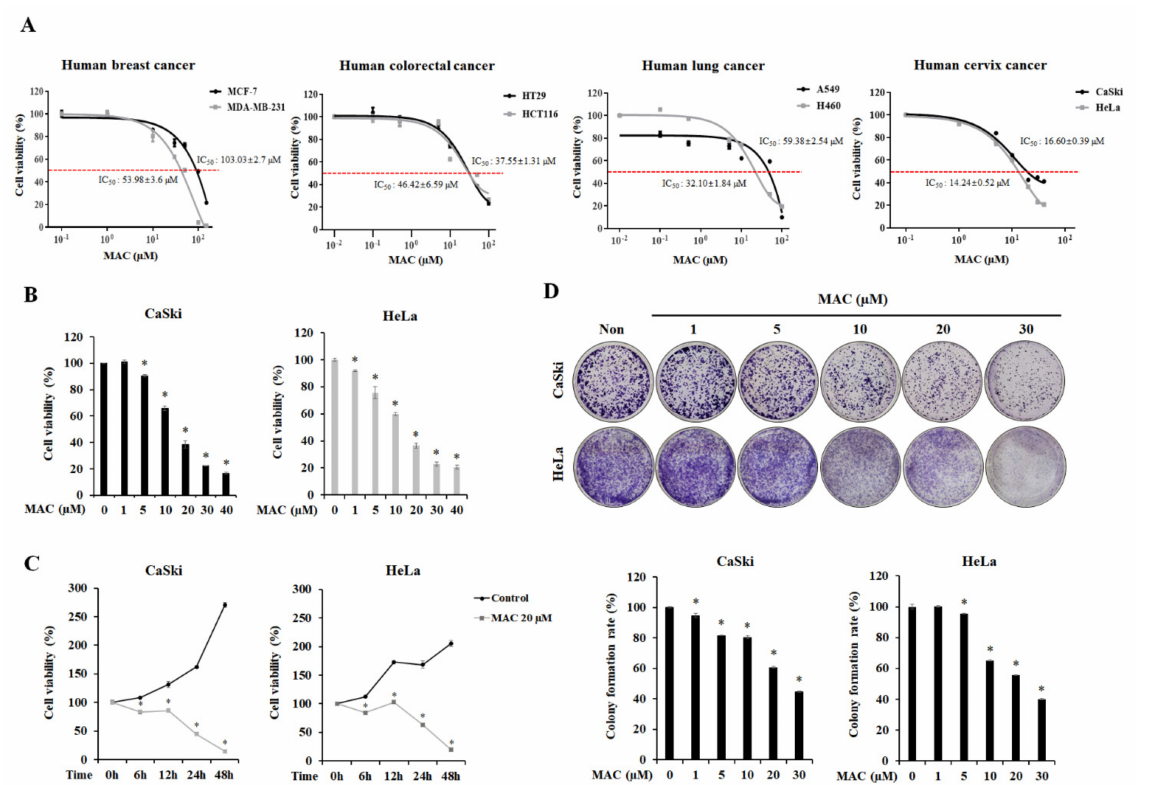
Figure 1. 4-O-methylascochlorin (MAC) suppresses the cell viability and proliferation in cervical carcinoma cells. ( A ) Various cancer cells treated with different doses of MAC were evaluated using the WST-8 assay, and IC 50 values were calculated using Excel. MAC IC 50 values against each cell line are the mean of three separate investigations ( n = 3). ( B ) CaSki and HeLa cells were treated with MAC at concentration of 1, 5, 10, 20, 30 and 40 µ M for 24 h. ( C ) Cells were incubated with 20 µ M of MAC for 6, 12, 24, and 48 h. Additionally, viability was determined by WST-8 assay. ( D ) Cells were incubated with indicated dose of MAC for 24 h, followed by staining with crystal violet to detect the cell proliferation. The rate of colony formation was measured by the absorbance at 562 nm. Values represent the means ± SD of triplicate assays. * p < 0.05 vs. control. Results were analyzed using one-way ANOVA followed by Bonferroni post hoc